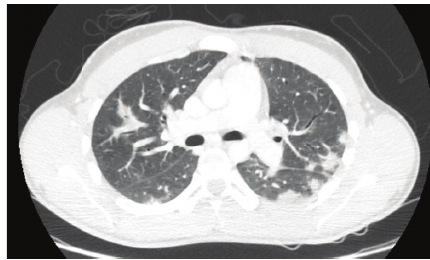
Figure 2: Multiple pulmonary